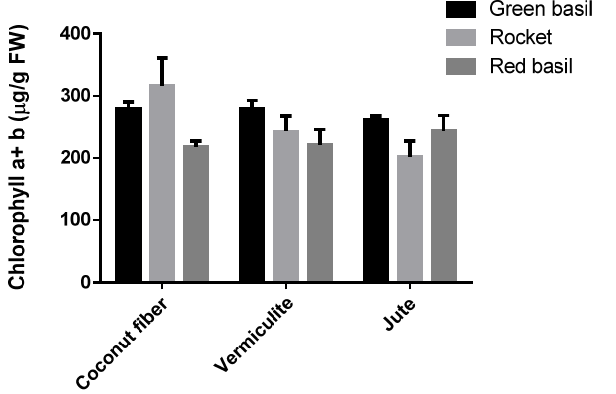
Figure 7. Chlorophyll a + b concentration of green basil, rocket, and red basil microgreens grown on three different substrates. Values, subjected to two-way ANOVA, are means ± SE (n = 6).